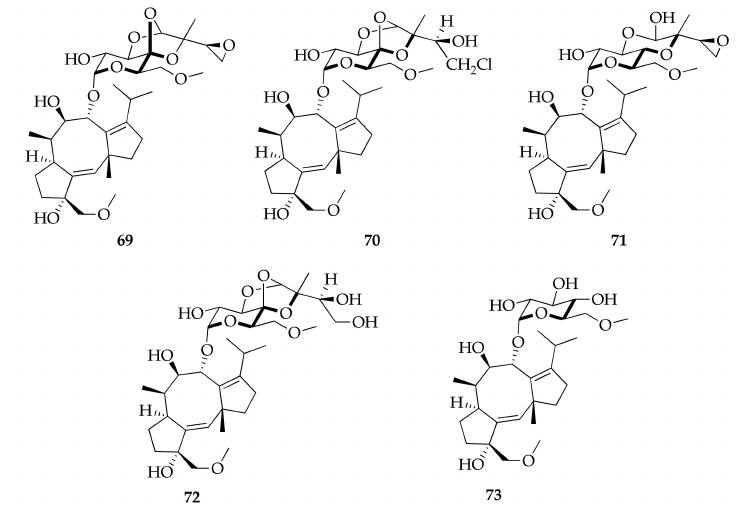
Figure 16. Structures of fusicoccane diterpene glycosides.